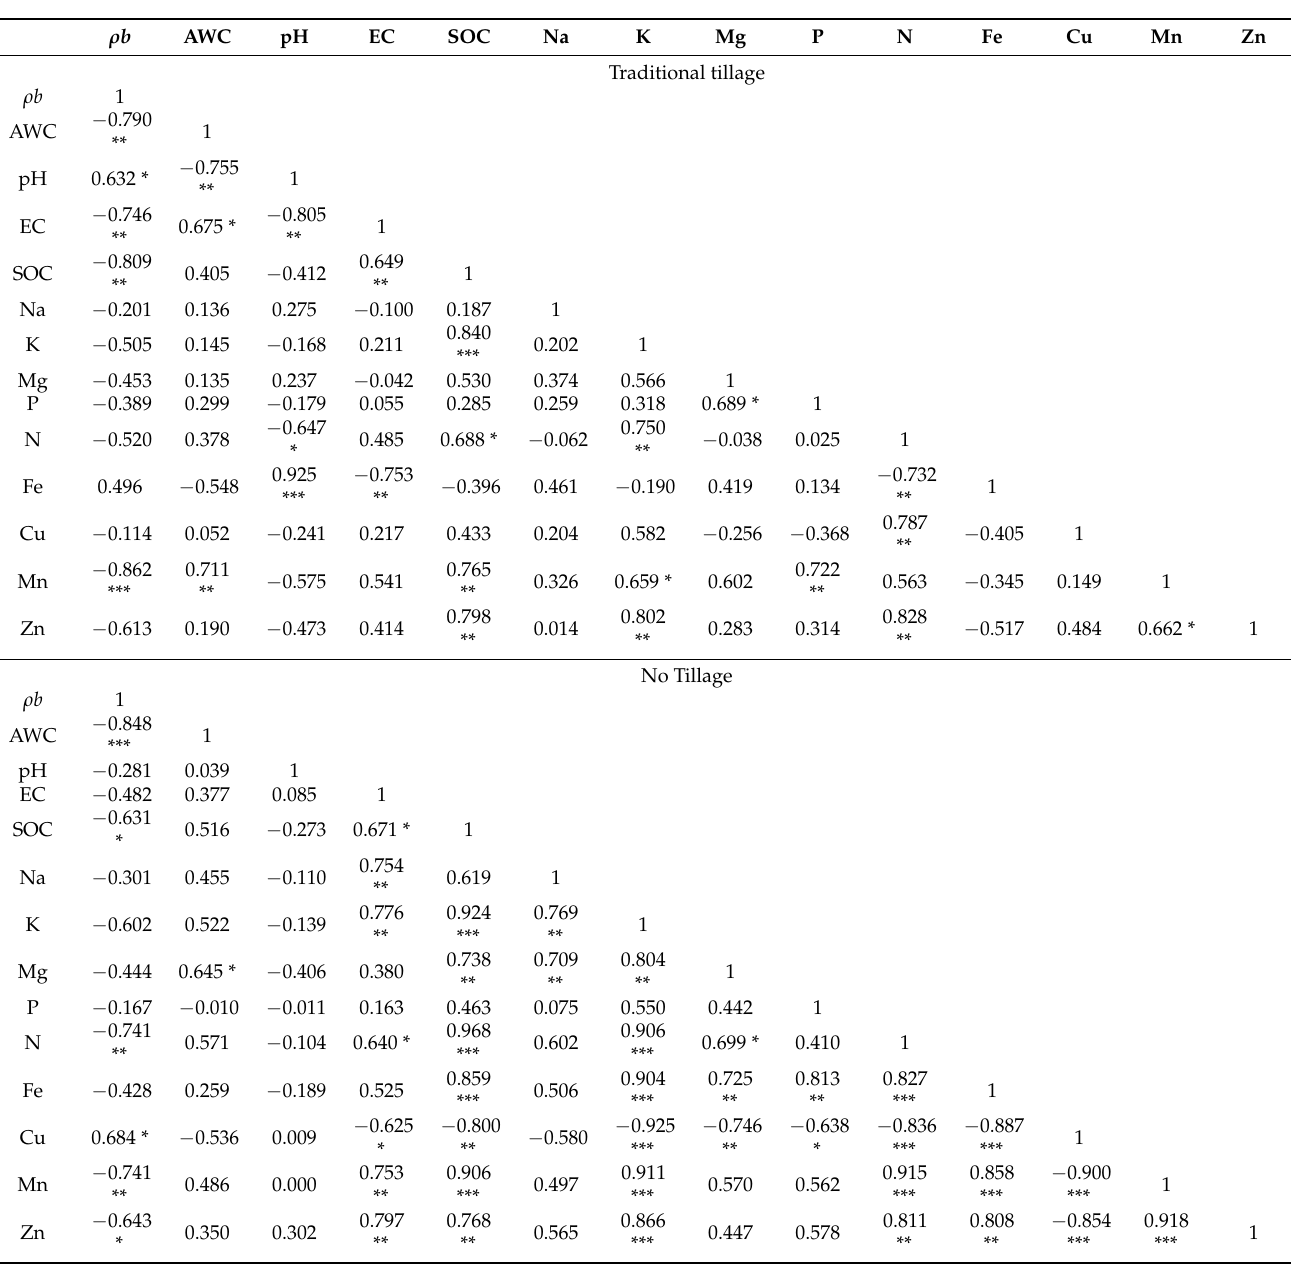
Table 4. Correlation matrix of different soil parameters, irrespective of depth, for each